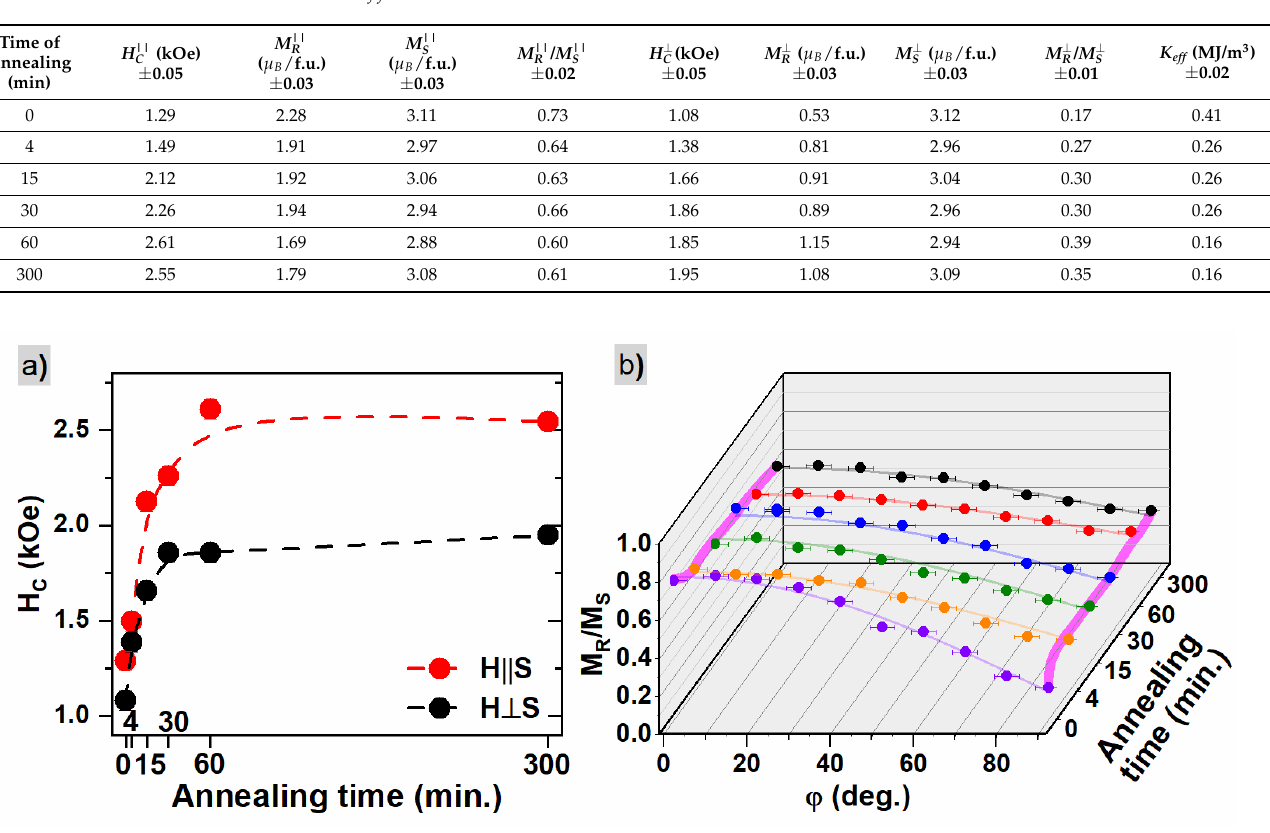
Figure 5. ( a ) Coercive field H C vs. annealing time for in-plane and out-of-plane geometries and ( b ) angular dependence of the M R / M S ratio where different colors are for samples annealed with different time.